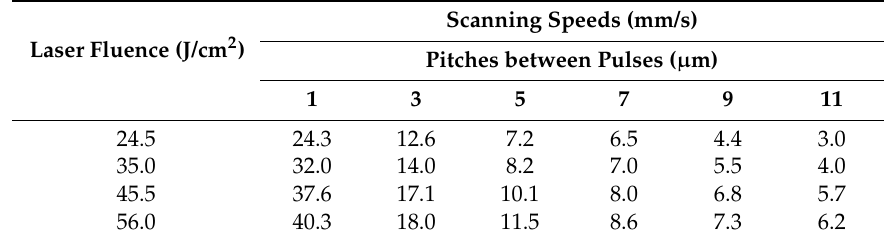
Table 1. Averaged height ( µ m) of PDMS replica (or averaged depth of PTFE surface) under varied laser fluences and sample scanning speeds.